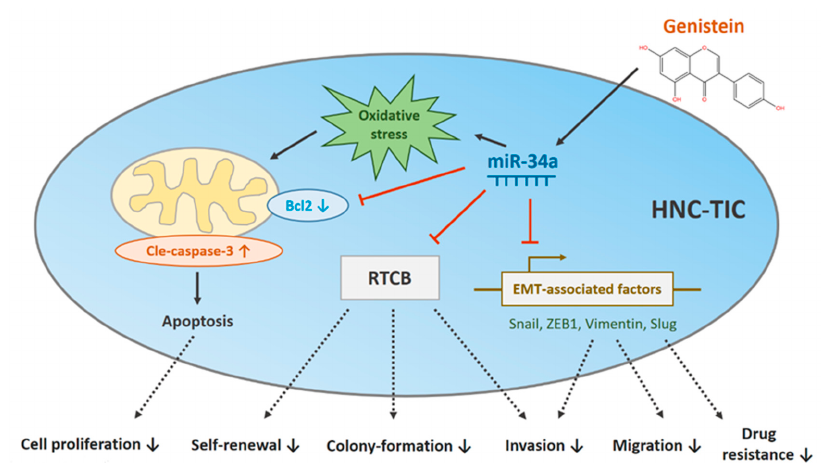
Figure 8. Proposed antineoplastic mechanism for oxidative stress-mediated genistein. HNC-TIC: tumor-initiating cells of head and neck cancers; ZEB1: zinc finger E-box binding homeobox 1; RTCB: RNA 2',3'-cyclic phosphate and 5'-OH ligase.